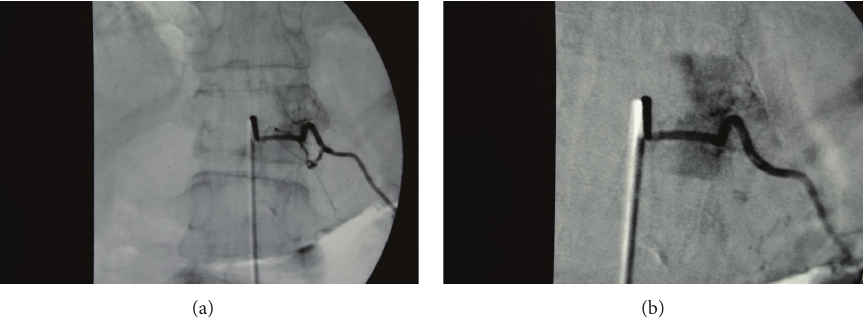
Figure 2: Case 1—unsubtracted (a) and subtracted (b) selective spinal angiogram performed within the left T11 spinal artery, anterior- posterior view, demonstrating position of catheter during treatment. Note the intense tumor blush involving most of the left hemivertebrae.